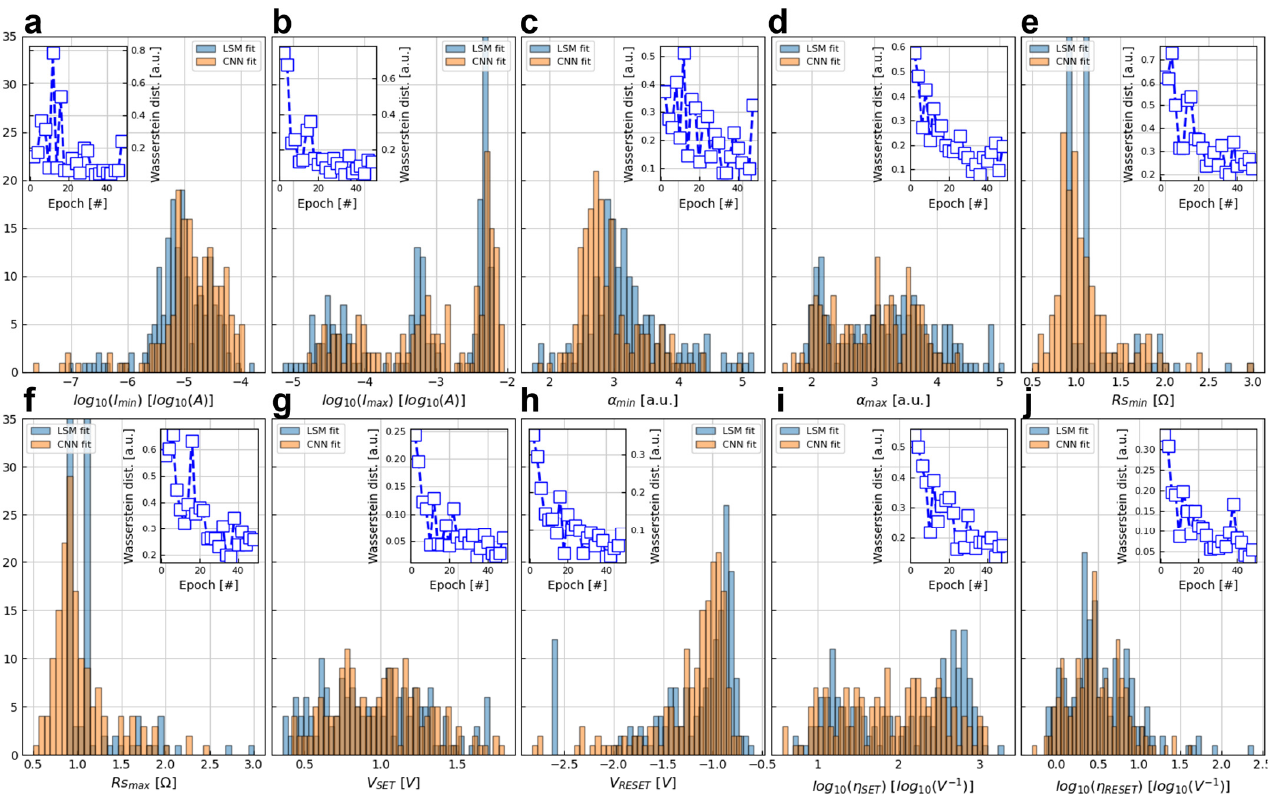
Figure 6. Comparison of the histograms of the estimated DMM parameters using the ANN (labelled as CNN fit) against the DMM parameters extracted by the simulator-in-the-loop approach (labelled as LSM fit). The ANN was trained over 50 epochs. Note the good match between both histograms. The Wasserstein distance in the inset quantifies the fitting improvement along the training.